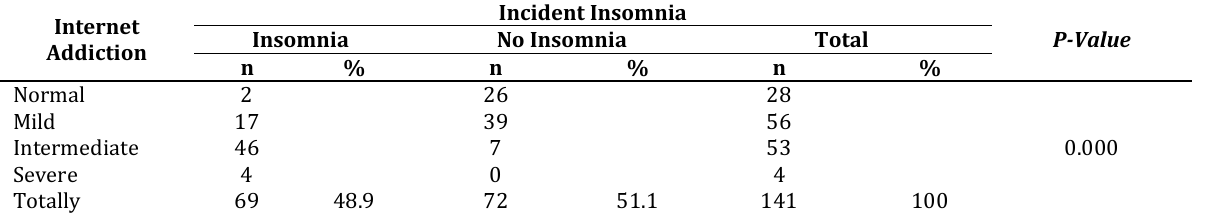
Table 2. Relationship between Internet Addiction and Insomnia (n=141)